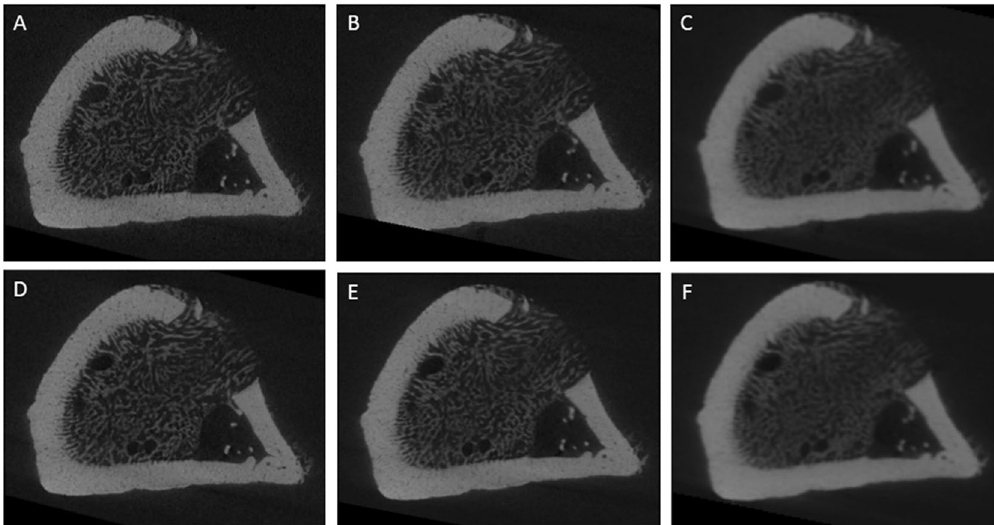
Figure 2. Representative section of the reconstructed data for each tested acquisition parameter: ( A ) Frame averaging = 1, data binning = 1; ( B ) Frame averaging = 1, data binning = 2; ( C ) Frame averaging = 1, data binning = 4; ( D ) Frame averaging = 2, data binning = 2; ( E ) Frame averaging = 2, data binning = 2; ( F ) Frame averaging = 2, data binning =